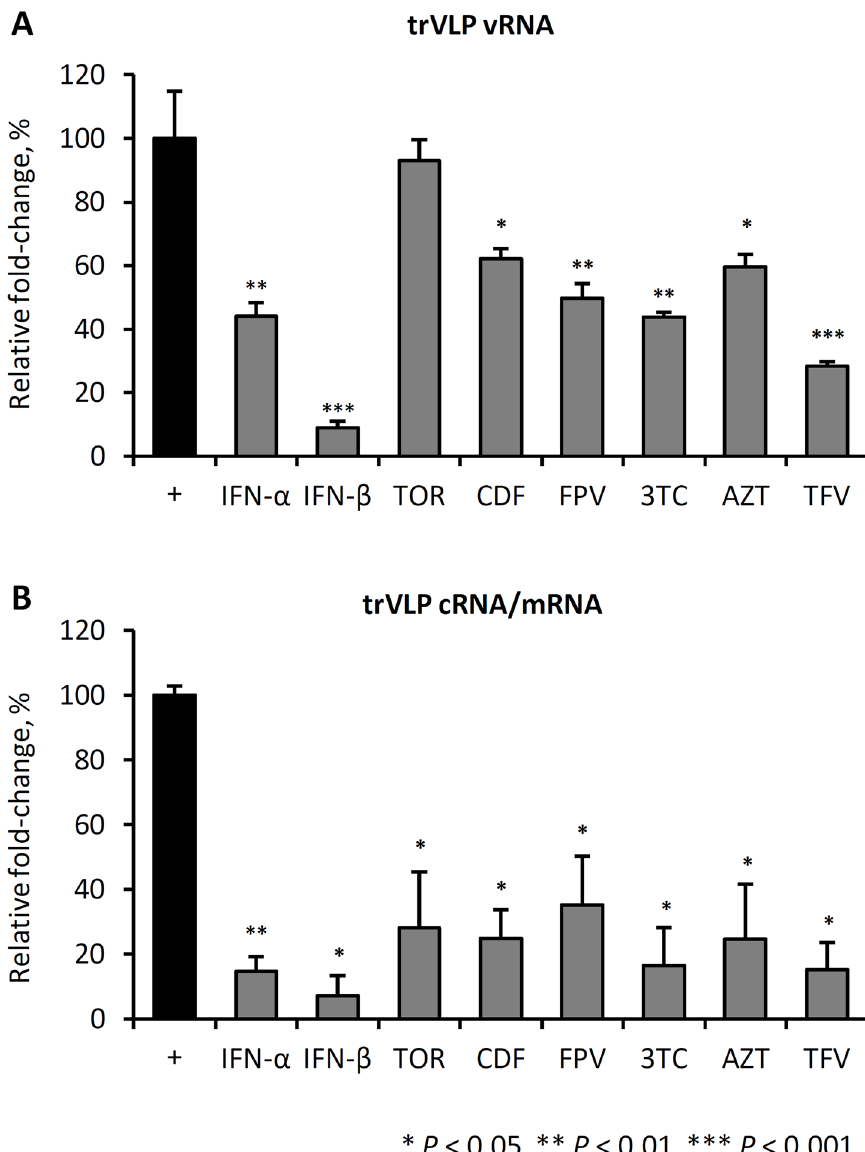
Fig 3. IFNs, toremifene and nucleoside analogs reduce trVLP replication and transcription. 293 T cells were transfected with support plasmids and infected with trVLP. 24 hours post-infection, cells were treated with the indicated drugs at their IC 50 doses, determined from Fig 2I. At 48hrs post-infection, total RNA was extracted, reverse transcribed, then quantified by qPCR. Relative fold-change in -ve sense vRNA transcripts (A) and +ve sense cRNA and mRNA (B) was compared with infected, untreated cells (solvent,+ control). Technical duplicates were examined by qPCR, and means are the average of three biological replicates. Error bars are the standard error around the